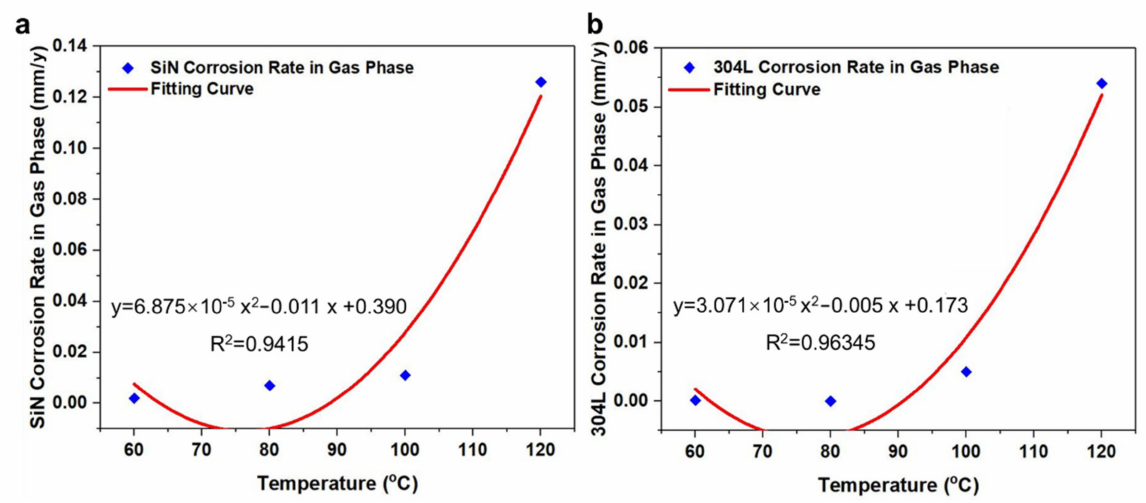
Figure 9. Corrosion rate fitting curves of SiN and 304L stainless steels in nitric acid vapor phase at different temperatures, ( a ) SiN stainless steel and ( b ) 304L stainless